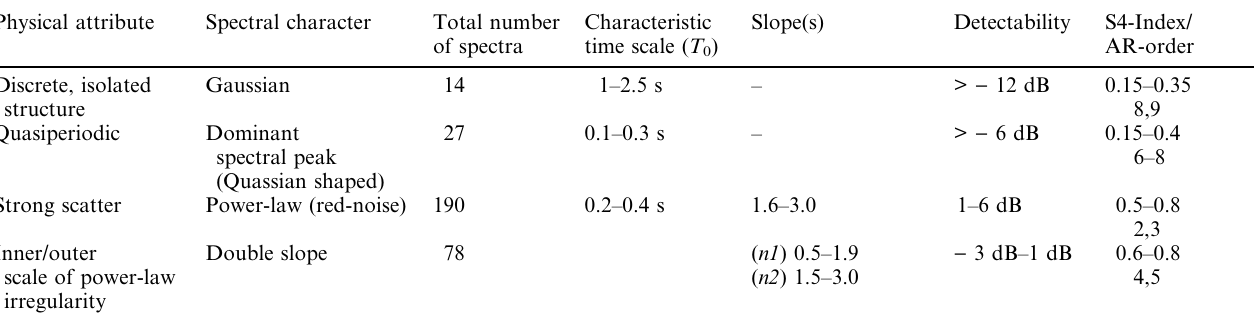
Table 2. Parameters from AR scheme of spectral analysis